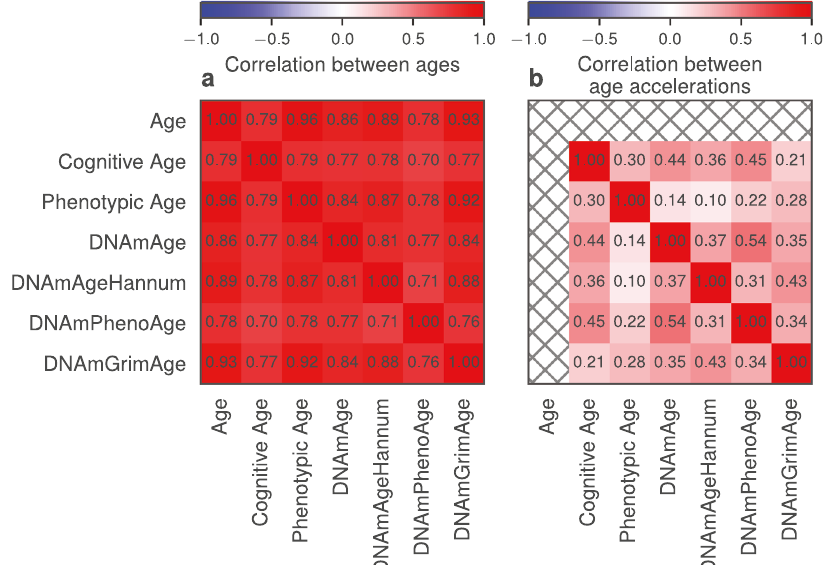
Fig. 5 Correlation analysis of ages and age accelerations. Pairwise correlations between ages ( a ) and age accelerations ( b ). The cell of heatmaps shows the Pearson correlation coef fi cient between different types of ages and age accelerations.